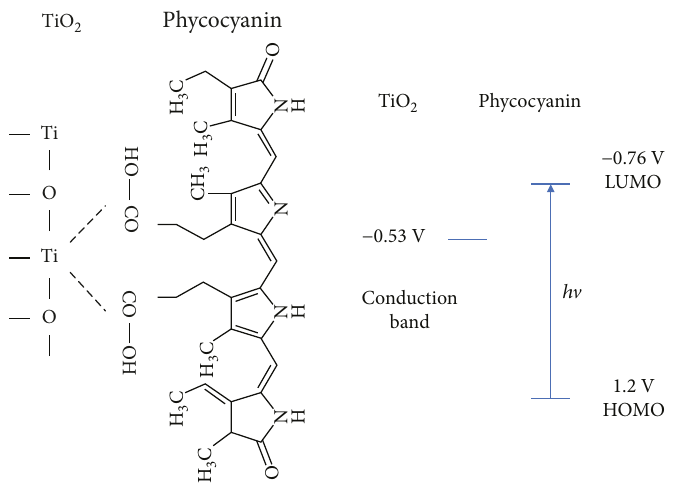
Figure 4: Hypothetical sensitization process and energy levels for phycocyanin sensitization [31,